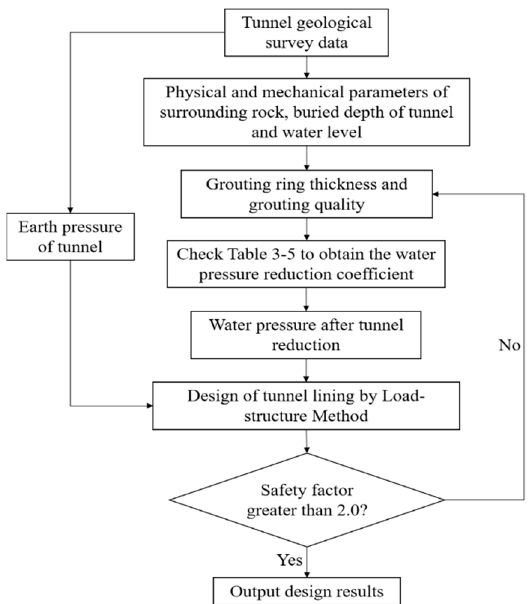
Figure 12. The design procedure of tunnel lining by water pressure reduction coefficient method.